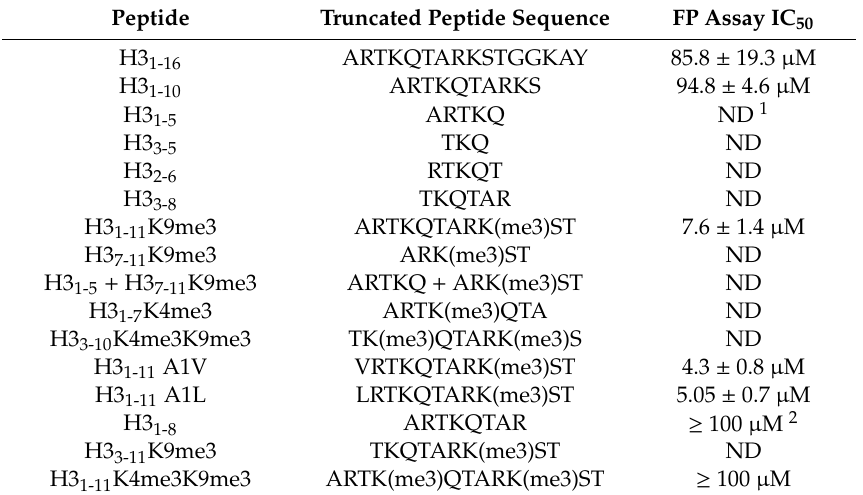
Table 5. Disruption of the H3 1-15 K9me3:ATRX ADD PPI by modified H3